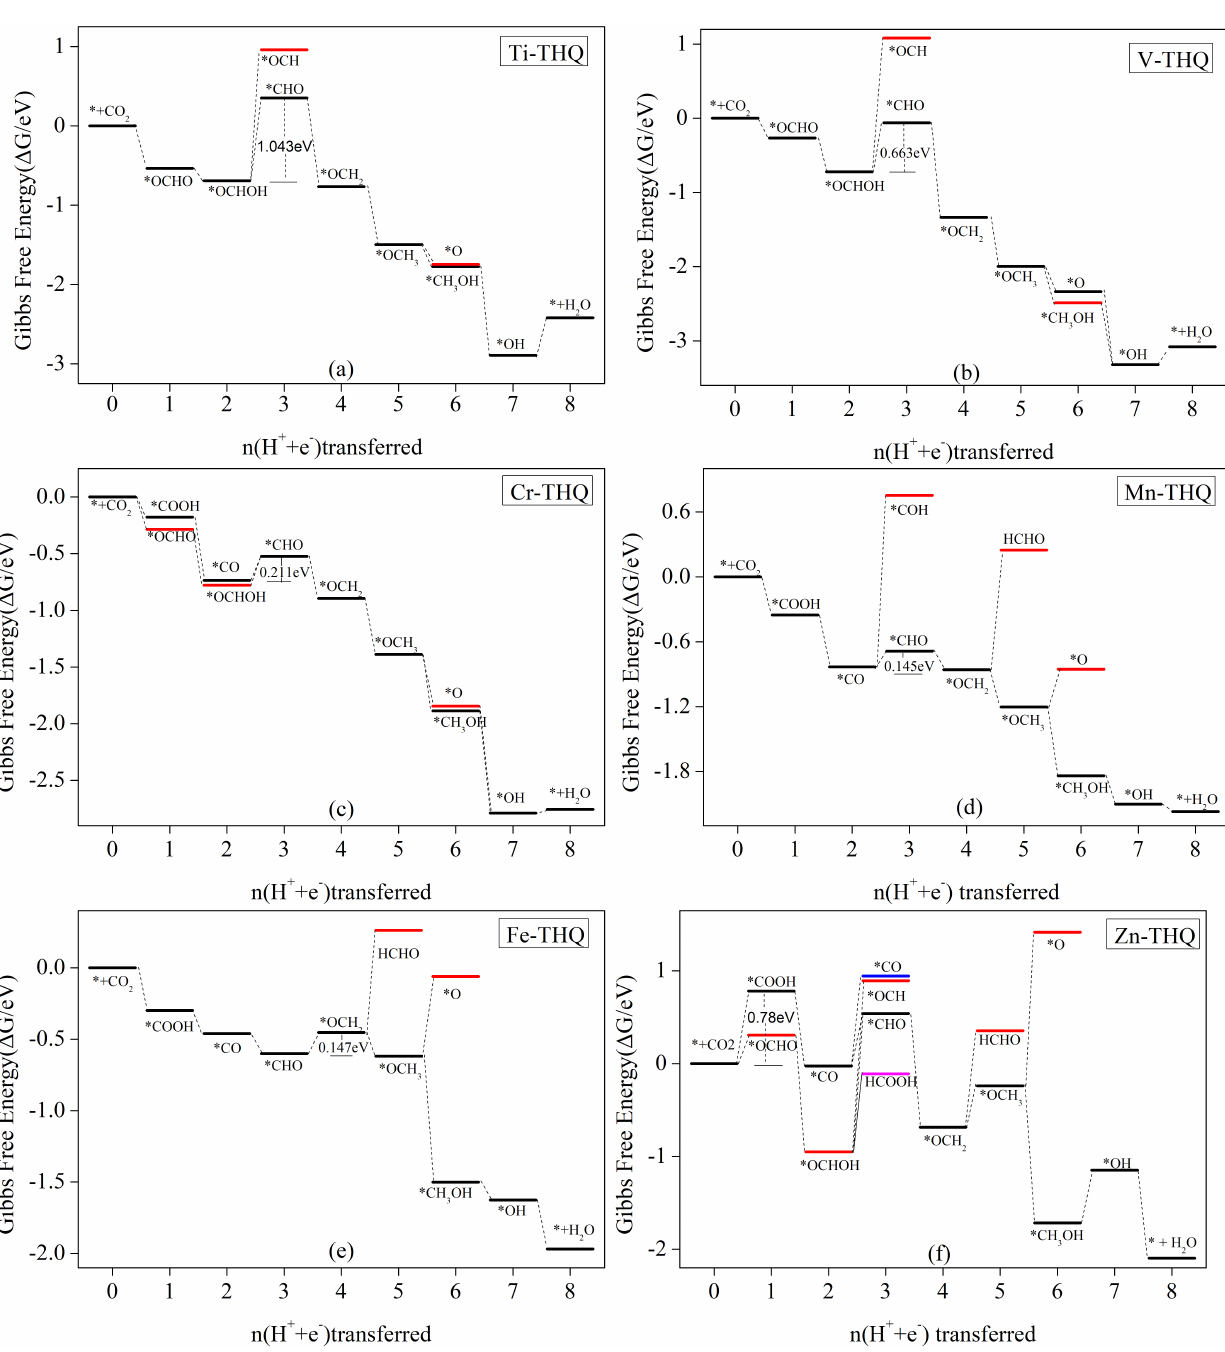
Figure 8. Gibbs free energy curves for ( a ) Ti-THQ, ( b ) V-THQ, ( c ) Cr-THQ, ( d ) Mn-THQ, ( e ) Fe-THQ, and ( f ) Zn-THQ, at zero potential, along the most favorable path of the CO 2 RR. The free energy zero point was set as the carbon dioxide molecule in the gaseous phase with a squeaky clean surface for the